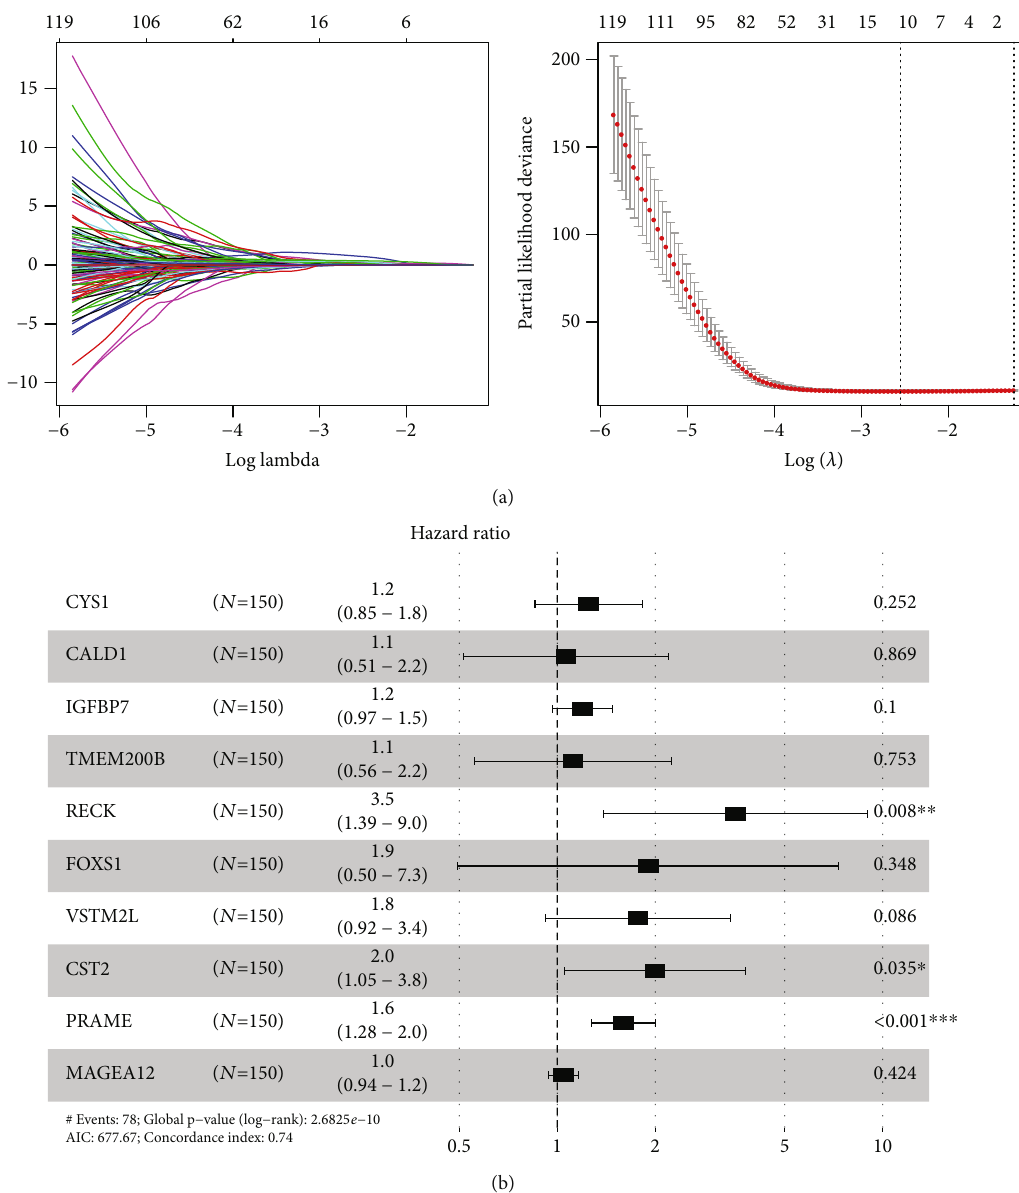
MAGEA12PRAMECST2VSTM2LFOXS1RECKTMEM200BIGFBP7CALD1CYS1 (N=150)(N=150)(N=150)(N=150)(N=150)(N=150)(N=150)(N=150)(N=150)(N=150)